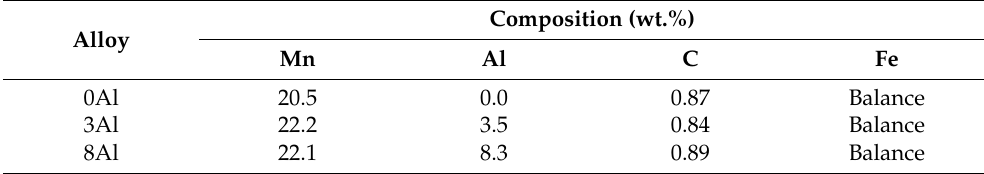
Table 1. Chemical composition of the alloys. Alloy